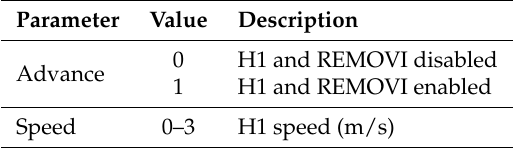
Table 8. H1 to PC data frame. FSR: force-sensing resistors.